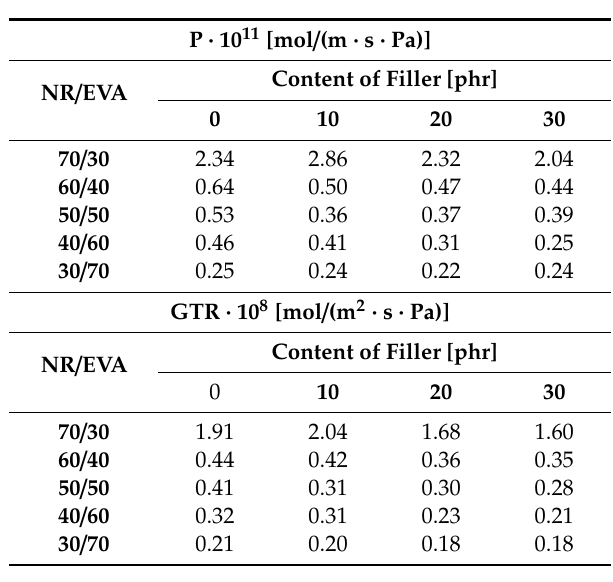
Table 4. The barrier properties of polymer blends based on natural rubber and ethylene–vinyl acetate copolymer filled with